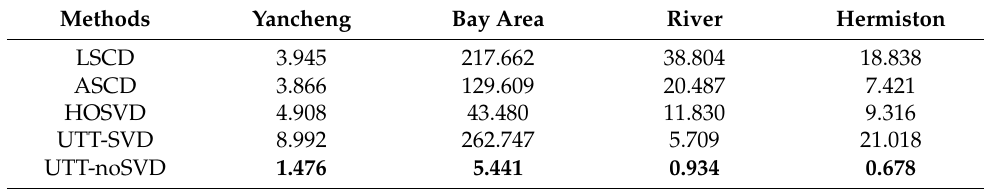
Table 4. Execution time of various methods using different experimental datasets (seconds).